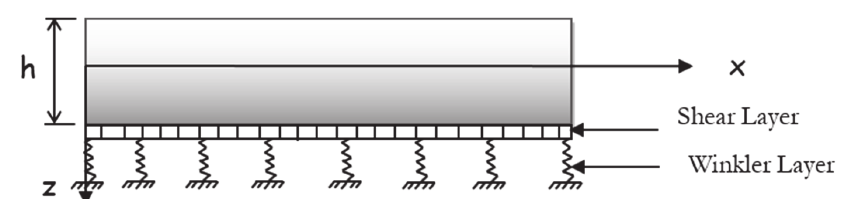
Figure 1: FGM beam supported by Winkler–Pasternak type elastic